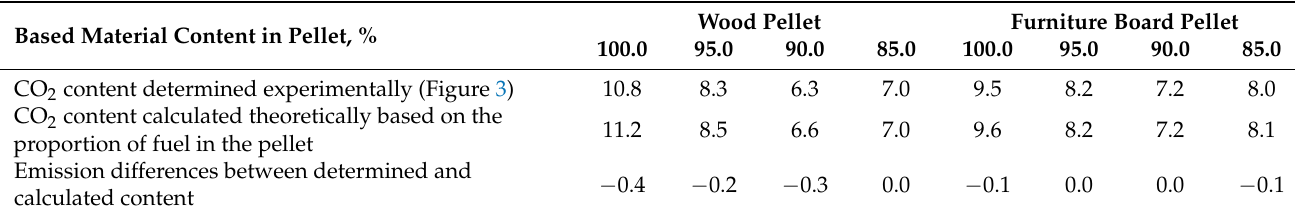
Table 6. Analysis of carbon dioxide content in flue gases.